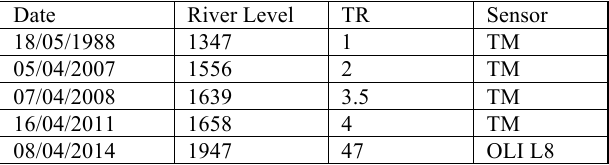
Table 1: Remote sensing images and river levels